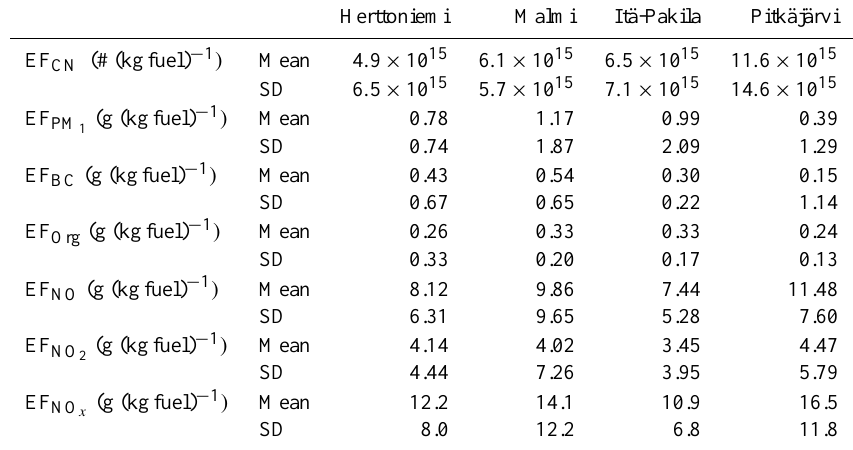
Table 3. Average emission factors along with standard deviations calculated from the measurements on the